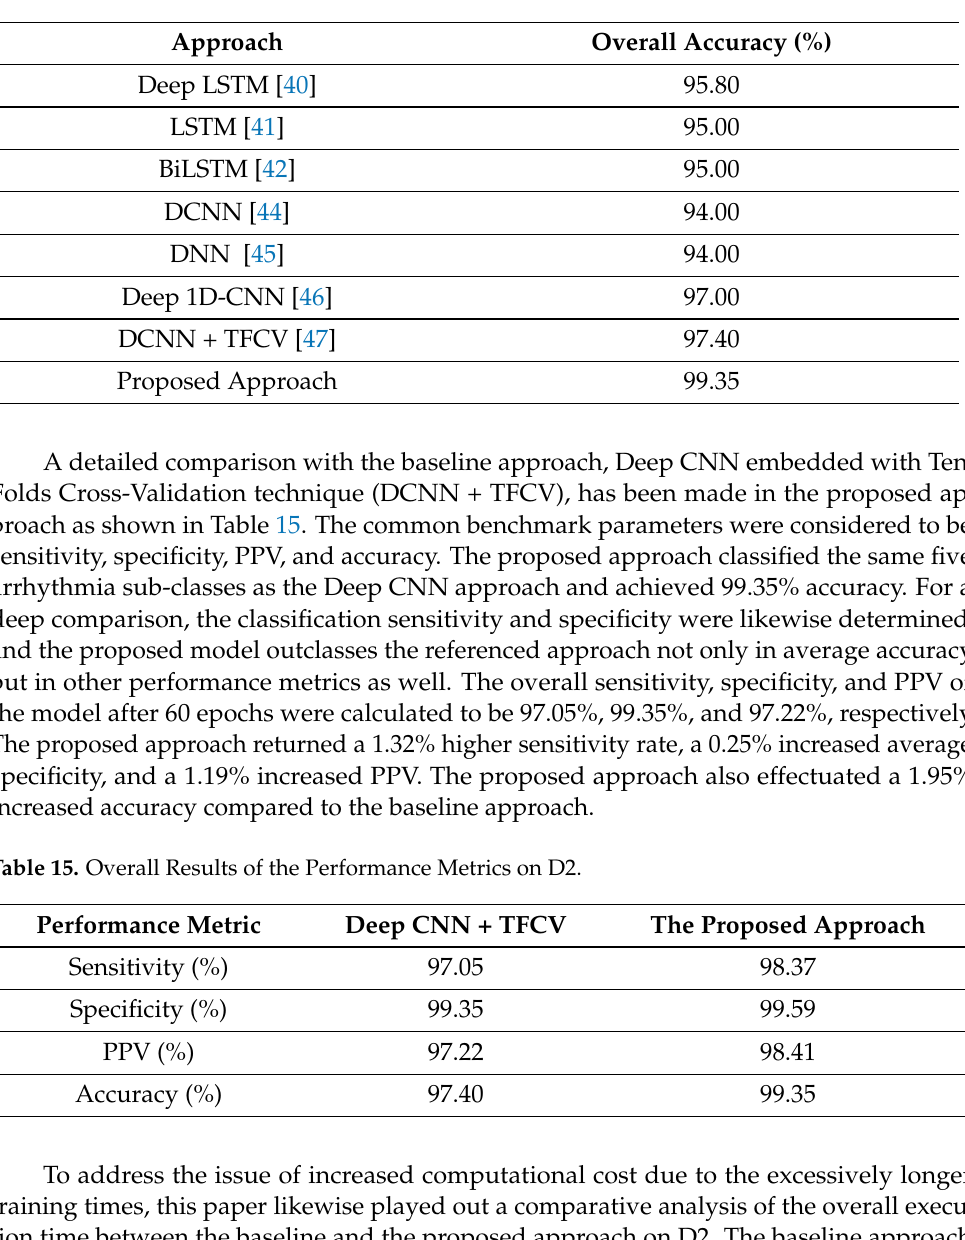
Table 14. Overall Accuracy of the Proposed Approach and Referenced Deep-Learning Approaches on D2.